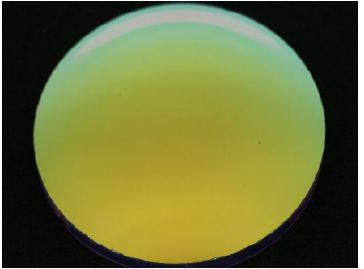
Figure 1. The picture of the notch filter sample.